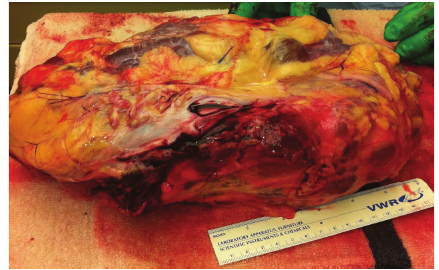
Figure 3: Left kidney 3450 grams.